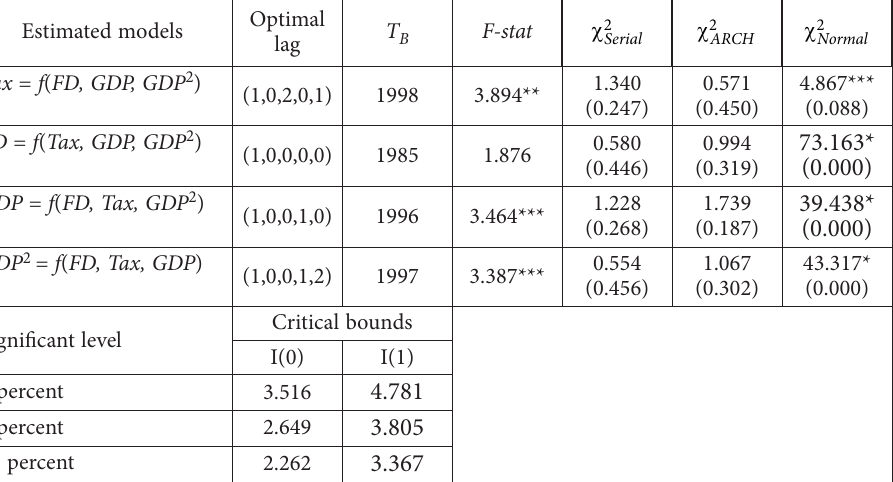
Table 5. The results for ARDL cointegration test